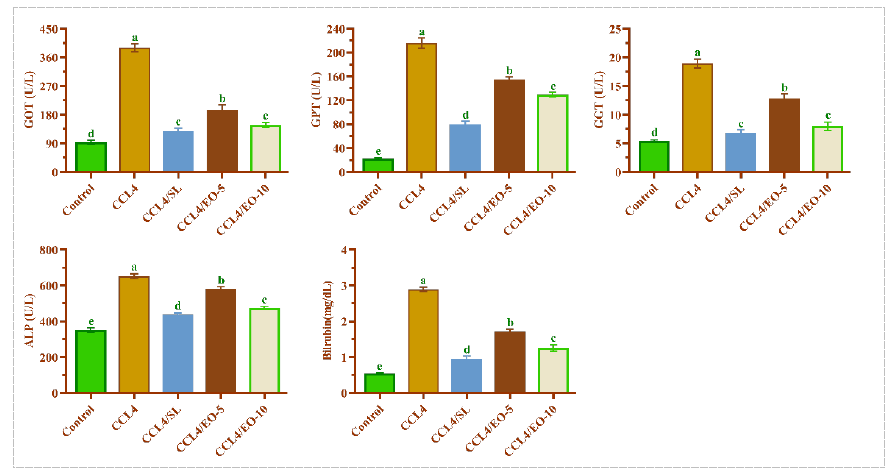
Figure 6. Effect of EO extracted from T. patula on liver function markers of rats treated with CCL 4 . Data represented as mean ± SD ( n = 6). CCL 4 : Carbon tetrachloride; SL: Silymarin; EO-5: Essential oil (5 mg/kg BW); EO-10: Essential oil (10 mg/kg BW); GOT: Glutamic oxaloacetic transaminase; GPT: Glutamic pyruvic transaminase; GGT: Gamma-glutamyl transpeptidase; ALP: Alkaline phosphatase. Different letters indicate statistically significant differences between groups at ( p < 0.05).